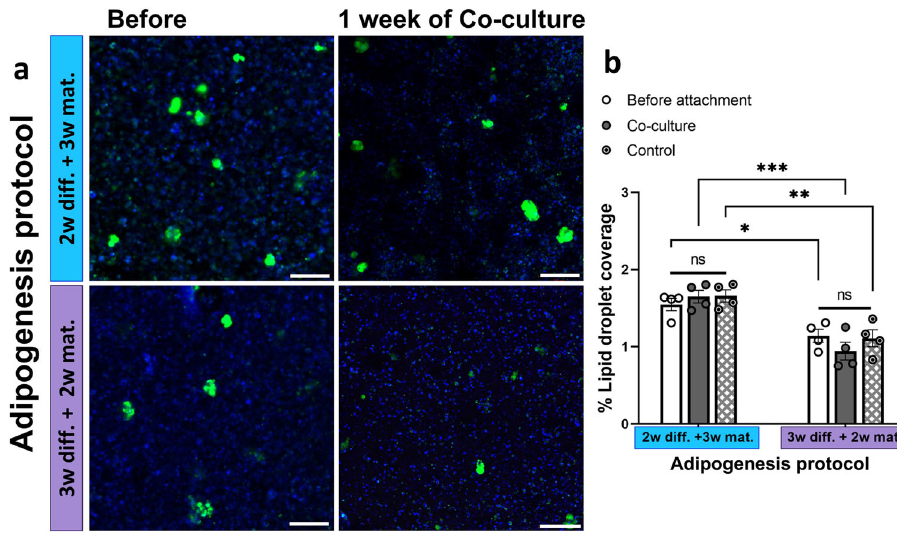
Fig. 5 Comparative analysis of mature adipocytes within marble-like constructs. a Confocal images of lipid staining of the ring-shape integrated constructs before the integration procedure versus after integration and 1-week co-culture, for 2 types of adipose constructs; 2-week differentiation followed by 3-week maturation ( ‘ 2w diff. + 3w mat. ’ ) and 3-weeks differentiation followed by 2-week maturation ( ‘ 3w diff. + 2w mat. ’ ). The images were taken from the inner ring region of the integrated constructs (green, LipidTox; blue, DAPI), scale bar 200 µ m. b Lipid droplet coverage percentage of the Lipid-stained constructs before the integration procedure ‘ Before attachment ’ , after the integration procedure and 1-week co-culture in maturation medium ( ‘ Co-culture ’ ), and of constructs that contained only adipocytes (adipose construct that were integrated with non-cell scaffold) after the integration procedure and 1-week co-culture in maturation medium ( ‘ Control ’ ) for the ‘ 2w diff. + 3w mat. ’ and ‘ 3w diff. + 2w mat. ’ adipose constructs. n = 4, one-way ANOVA followed by Tukey ’ s post hoc test, ns: non-signi fi cant, error bars show standard